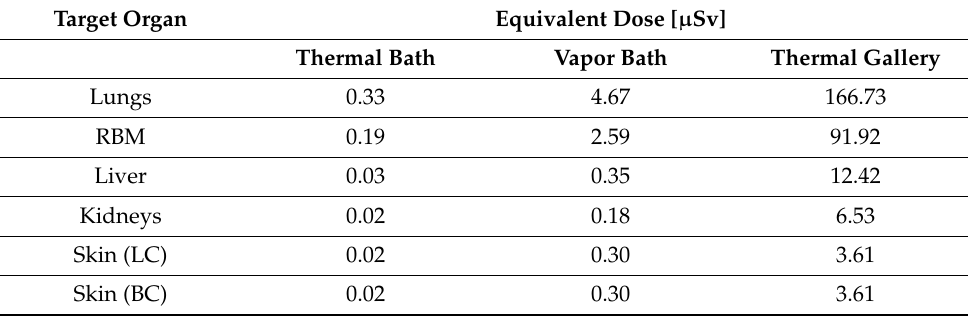
Table 3. Selected organ-specific equivalent doses for lungs, red bone marrow (RBM), liver, kidneys, and Langerhans cells (LC) and basal cells (BC) in the skin, resulting from the uptake of radon through the skin in the thermal bath, vapor bath, and thermal gallery [15]. Target Organ Equivalent Dose [ µ Sv] Thermal Bath Vapor Bath Thermal Gallery Lungs 333.90